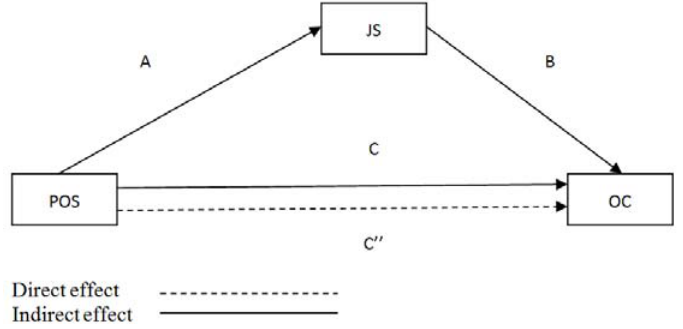
Fig. 1. Mediation analysis steps